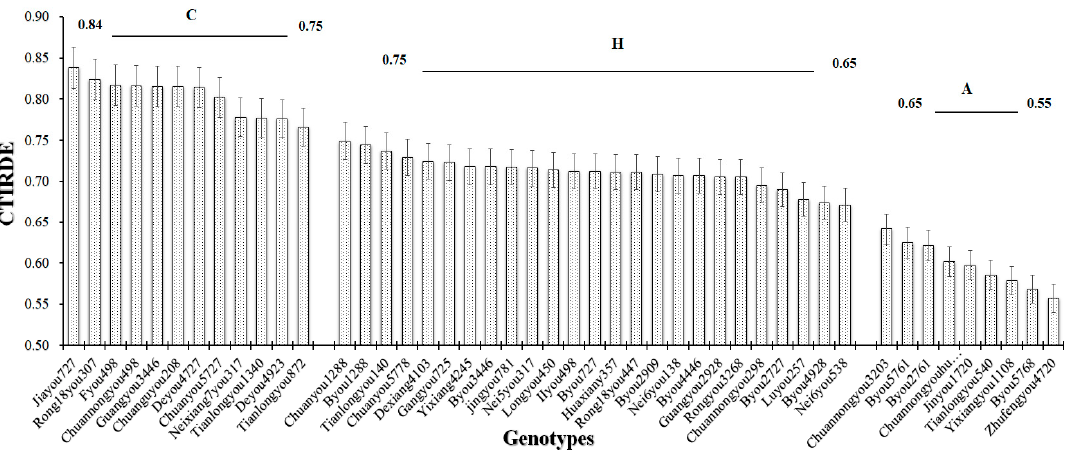
Figure 1. Forty-six rice varieties categorized into three groups on the basis of Complex Tolerance Index of Rice under Drought Environment (CTIRDE) values; rice varieties with CTIRDE values ranging from 0.75 to 0.84, 0.65 to 0.75, and 0.55 to 0.65 were categorized into the tolerant group (C), semi-tolerant group (H), and sensitive group (A), respectively.